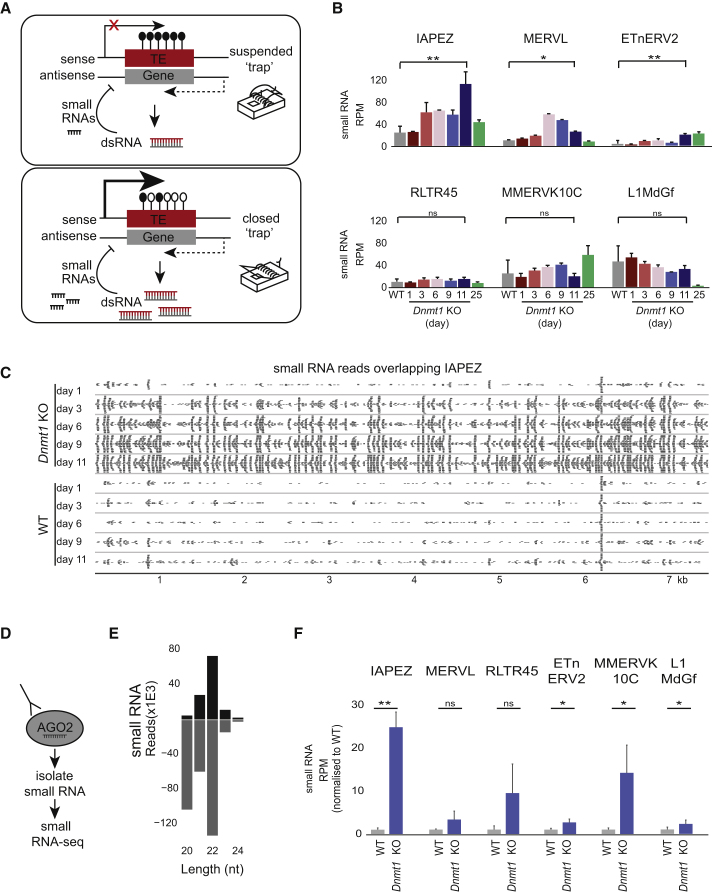
Generation of TE-Derived Small RNAs following Global Demethylation(A) Schematic displaying the hypothesis of pervasive transcription overlapping TEs acting as a “trap” of transcriptional activation of TEs. This could work through the production of dsRNAs from sense and antisense transcripts that feed into the RNAi pathway, which subsequently silences the TEs.(B) Small RNA-seq reads mapped to different classes of TEs from WT (gray) and conditional Dnmt1 cKO ESCs. ∗p < 0.05, ∗∗p < 0.005, two-tailed Student’s t test. Bars represent mean ± SD, n = 3. All reads of a size between 20 and 24 nt were mapped to TE consensus sequences.(C) Small RNA-seq reads mapped to the consensus sequence of IAPEZ. All reads of a size between 20 and 36 nt were mapped to the IAPEZ consensus sequence.(D) Schematic displaying AGO2 IP of small RNAs.(E) Size distribution of AGO2-bound small RNAs after AGO2 IP of sense (black) and antisense (gray) small RNAs mapping to repeatmasker consensus sequences using the piPipes small RNA-seq pipeline (Han et al., 2015).(F) Small RNA-seq of AGO2-bound small RNAs mapped to TE classes of WT (gray) and conditional Dnmt1 cKO ESCs induced for 9 days (light blue). ∗p < 0.05, ∗∗p < 0.005, two-tailed Student’s t test. Bars represent mean ± SD, n = 4.See also Figures S2 and S4I and Data S1.